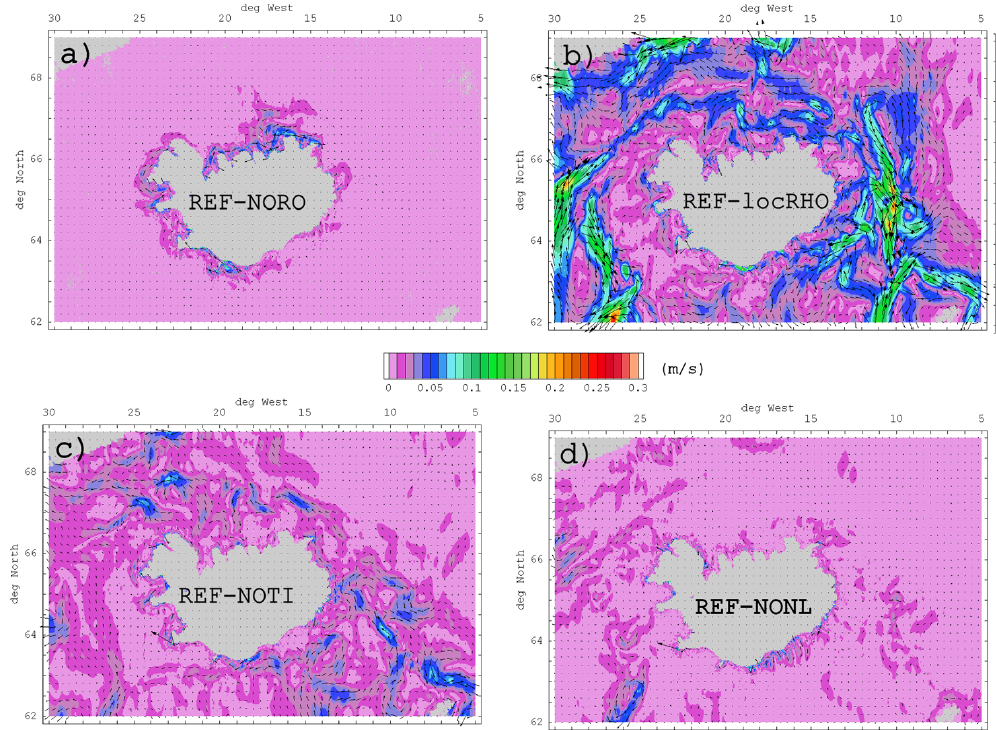
Fig. 16. Results of the sensitivity experiments NORO, locRHO, NOTI and NONL. Simulated mean flow fields at the depth of 15m subtracted from those of the reference run. Difference vector fields relating to (a) December 2003 mean of experiment NORO, (b) , (c) and (d) August 2003 to December 2003 means of experiments locRHO, NOTI and NONL, respectively. Note that the results of experiment locRHO are only relevant within the local area (Fig.